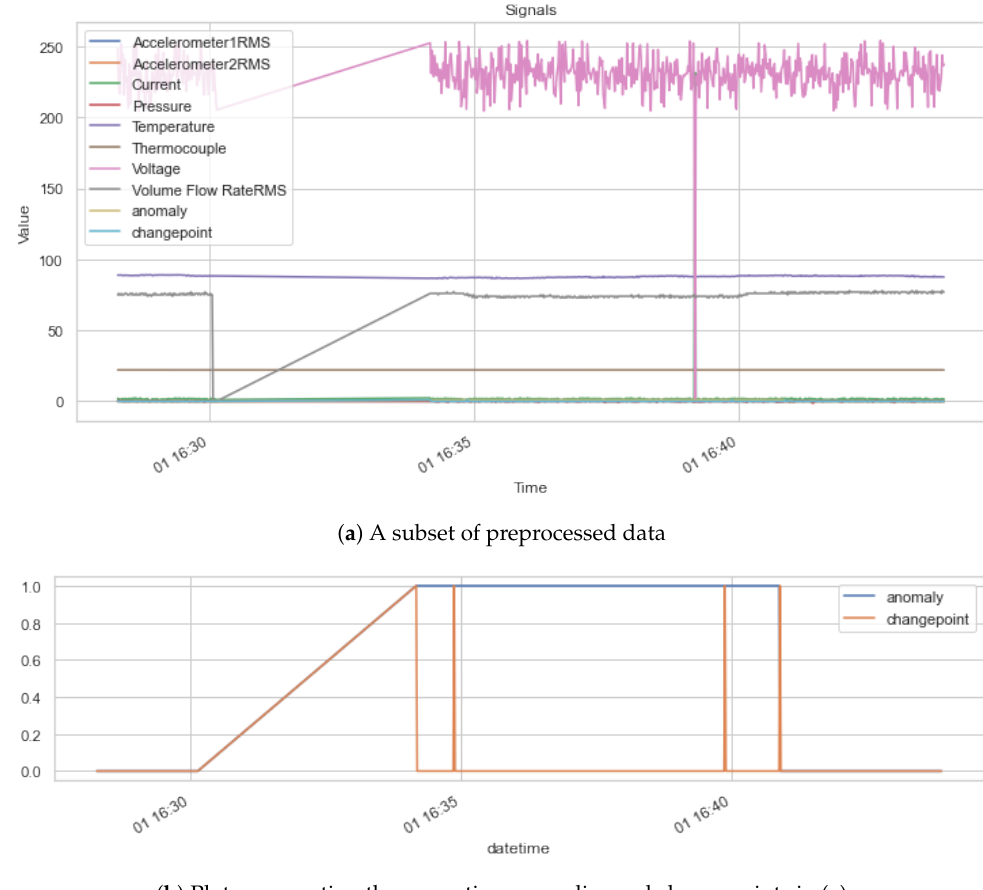
( b ) Plot representing the respective anomalies and changepoints in (a) Figure 9. Visualisation of the SKAB